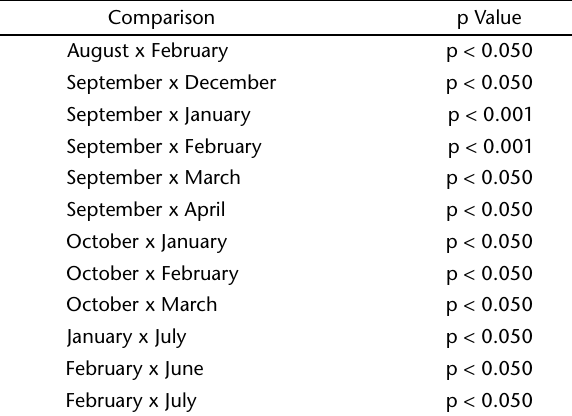
Table I. Results of Dunn’s test for the monthly values of the relative marginal increment (RMI) for C. edentulus in the Saco dos Limões bight (southern Brazil).